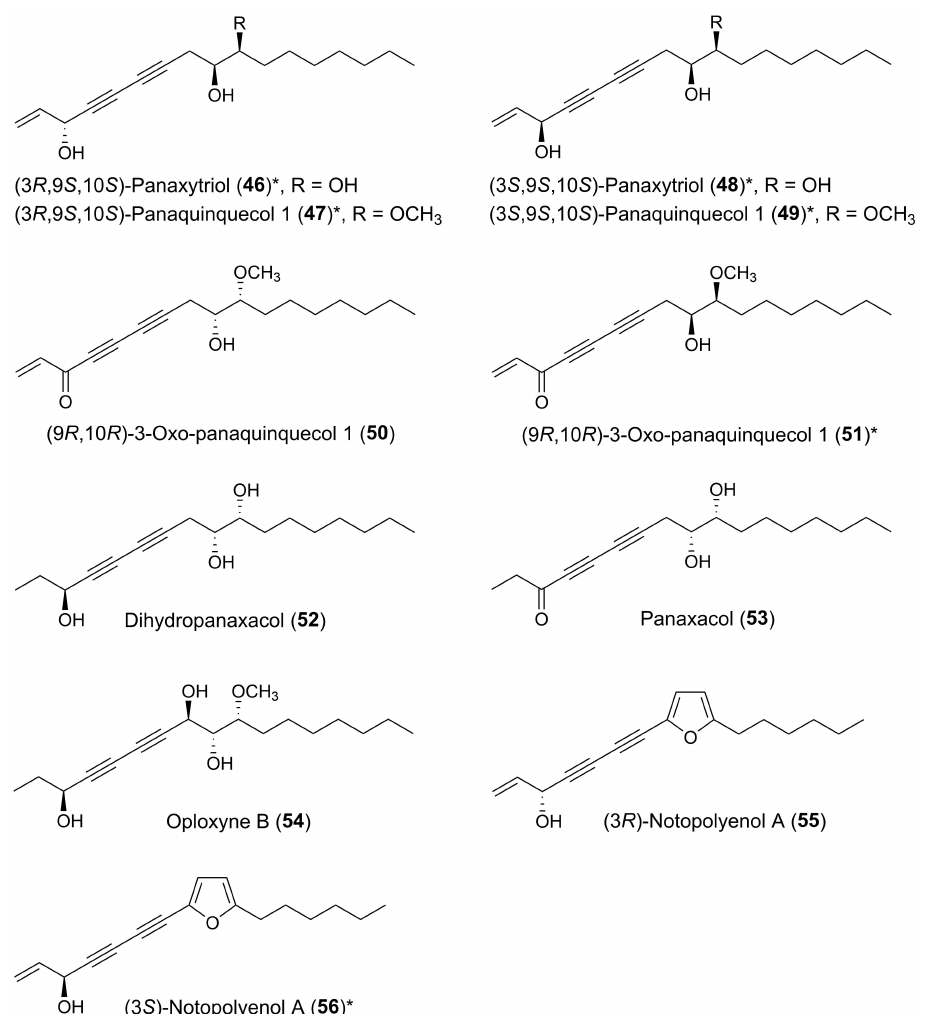
Figure 2. Cytotoxic C 17 acetylenic oxylipins ( 1 – 56 ) of the falcarinol-type. An asterisk (*) after a compound number indicates a cytotoxic falcarinol-type polyacetylene of synthetic origin that is not naturally occurring, but which may prove to be present in